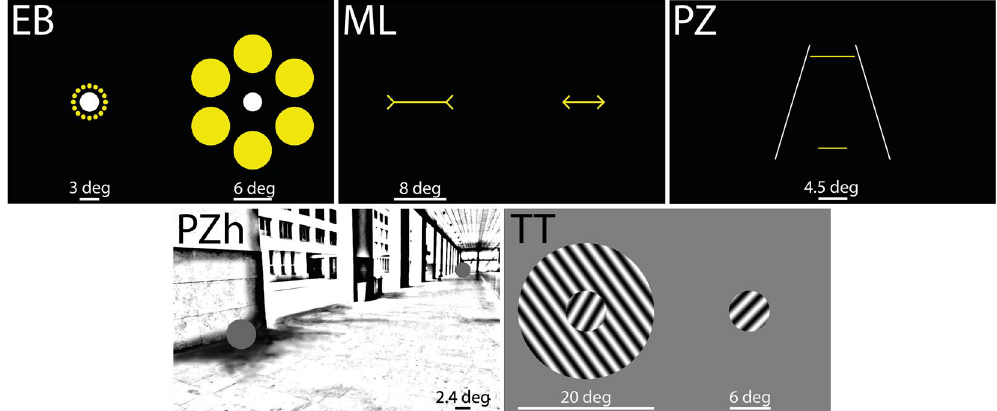
Figure 2. The five illusions tested. In each trial, participants adjusted one element of the stimulus in size, length or orientation to match it with a reference stimulus. The reference item for the Ebbinghaus (EB) was the white left disk and the adjustable element was the right white disk. For Müller-Lyer (ML), the reference item was the left line and the right line was the adjustable element. For Ponzo (PZ), the lower horizontal line was the reference item and the upper one was the adjustable element. For Ponzo-Hallway (PZh), the gray disk in the upper right corner was the reference item and the gray disk in the lower left corner was the adjustable element. In the Tilt illusion (TT), participants adjusted the orientation of the right grating to match the orientation of the inner grating of the stimulus presented on the left side of the